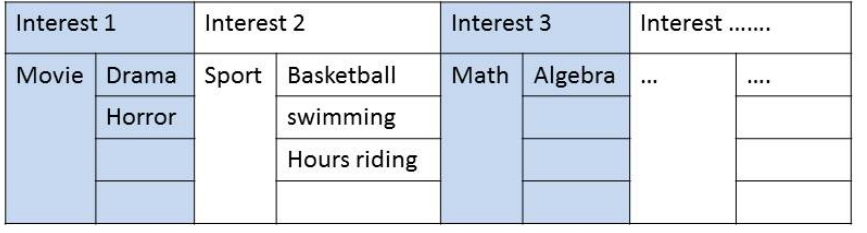
Figure 2. Interest list structure.